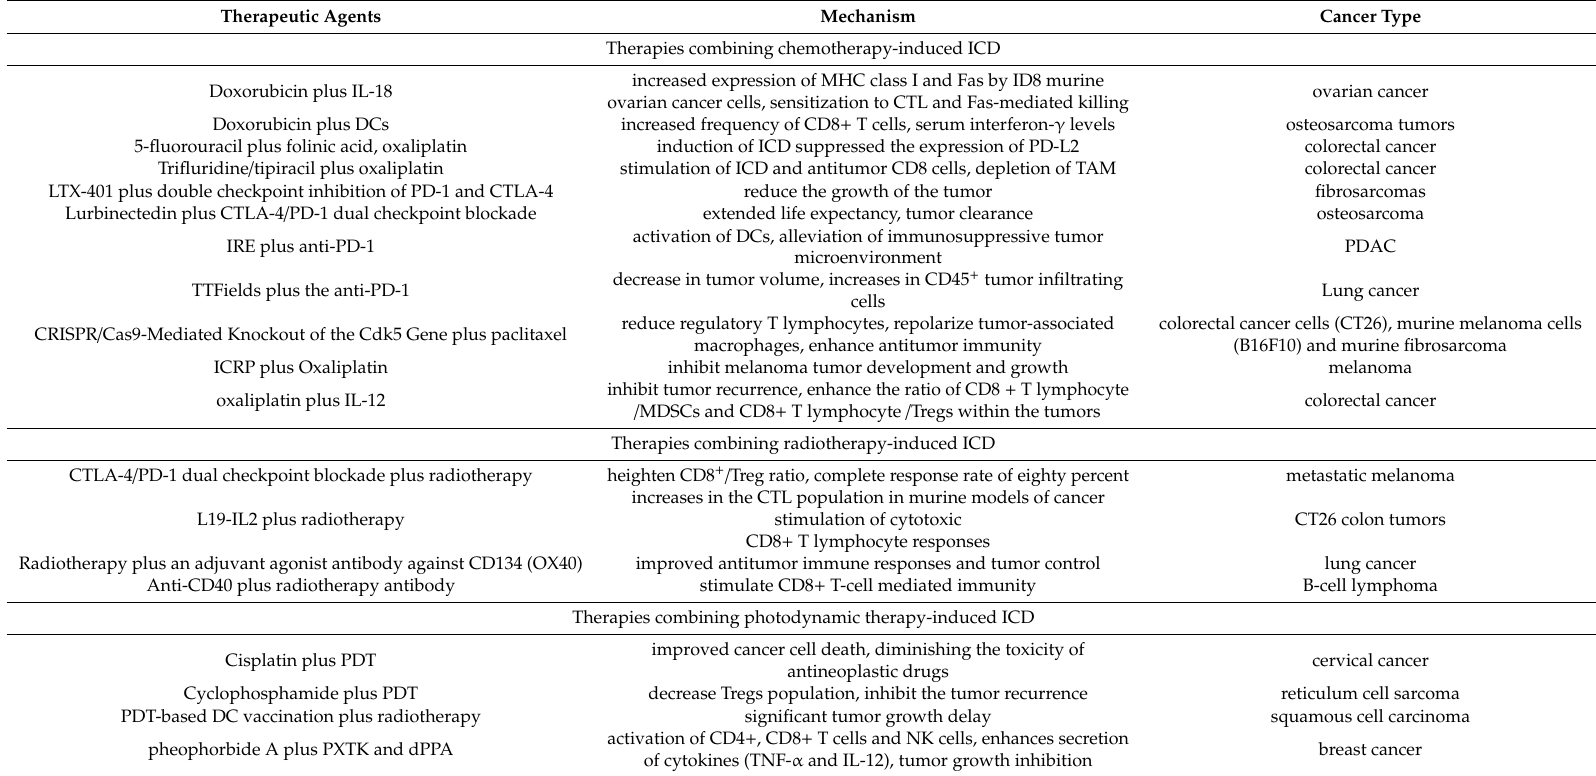
Table 2. ICD and combination therapy in